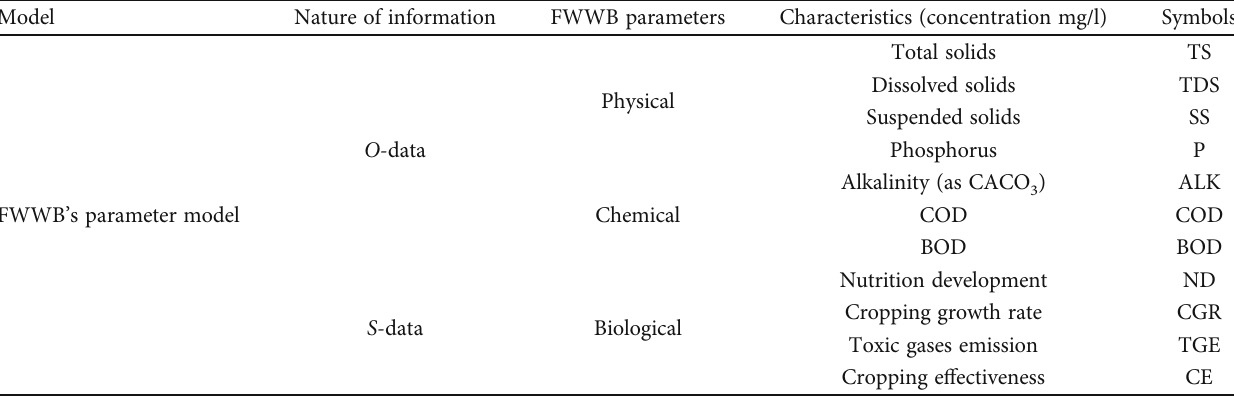
Table 1: Developed and proposed FWWB ’ s parameter model.